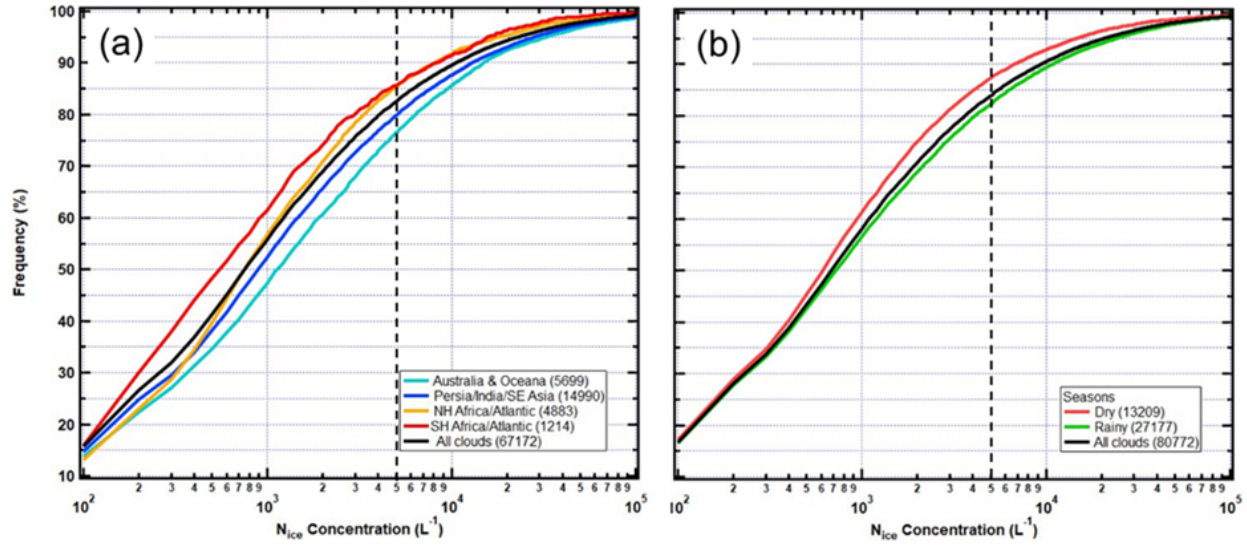
Figure 2. Frequency distribution of N ice for all measured ice crystal clouds (a) by region and (b) by dry/rainy season. The vertical dashed lines indicate the extreme ice event (EIE) threshold concentration.